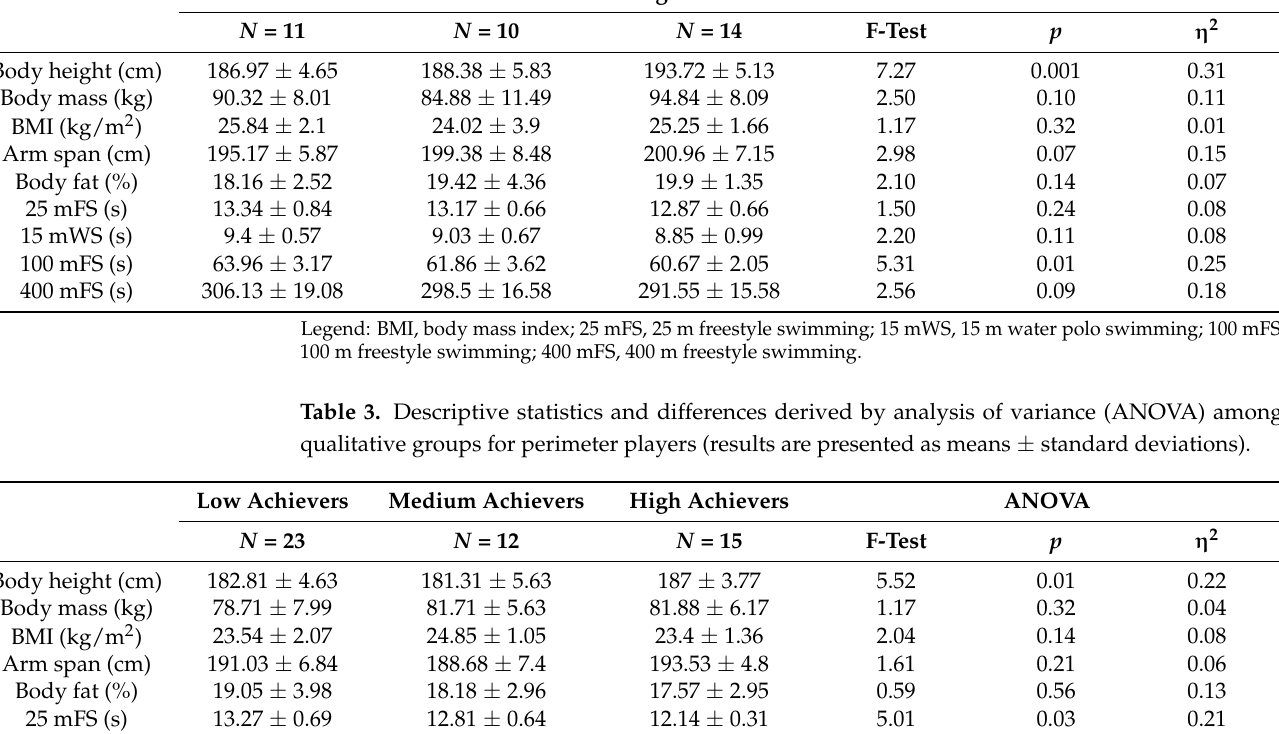
Multinomial regression results calculated for total sample are presented in Figure